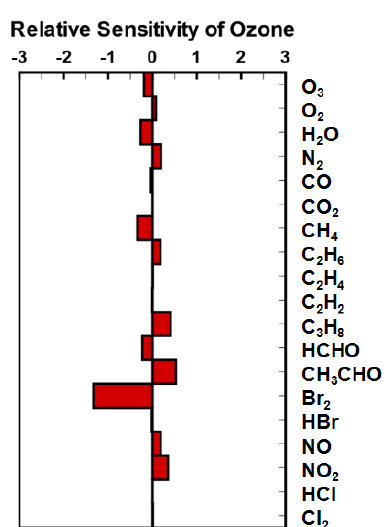
Figure 7. Relative concentration sensitivities of ozone under an initial NO